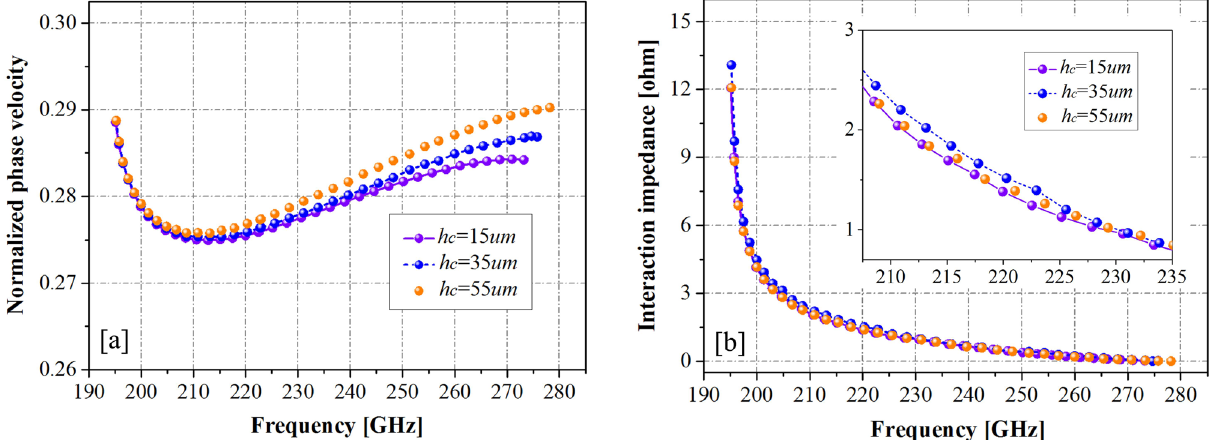
Figure 5. Dispersion properties and interaction impedances of the FRSWG SWS with different h c